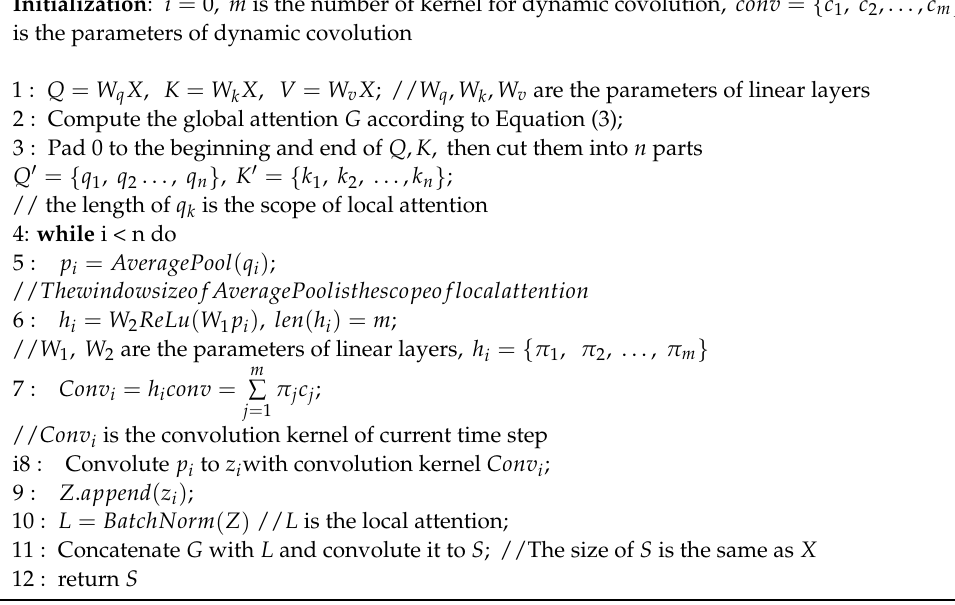
Algorithm 1. Dynamic convolution attention